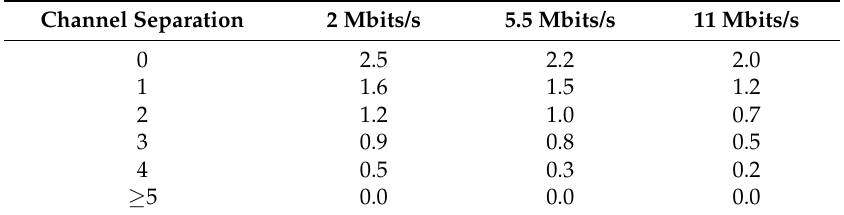
Table 1. Interference factor in an IEEE 802.11b